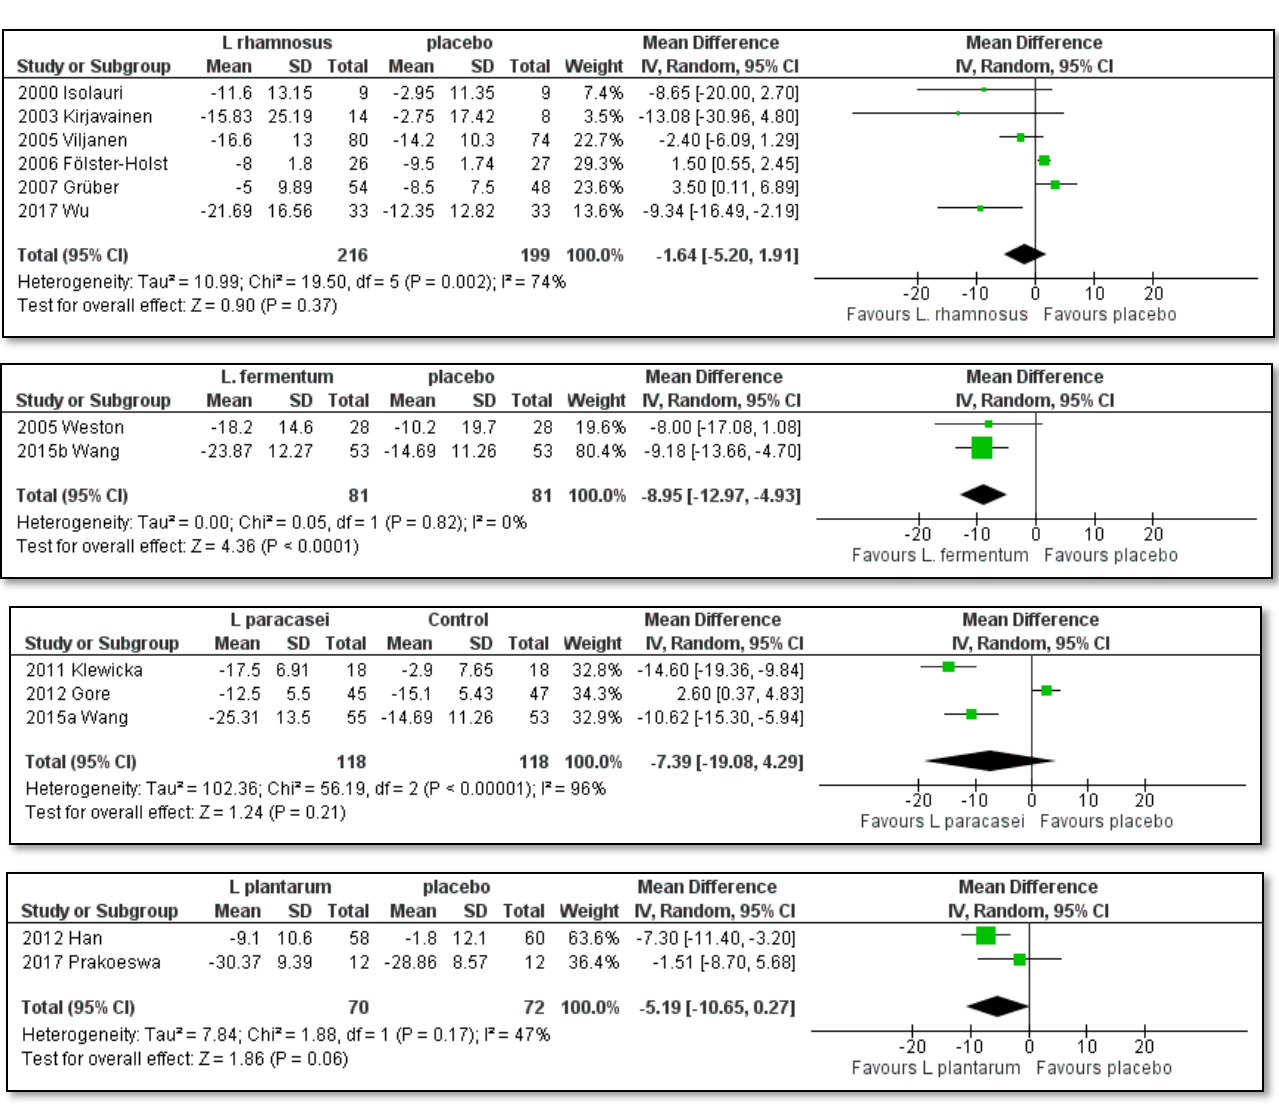
10 of 21 Figure 2. Meta-analysis of the e ff ect of single-strain probiotic lactobacilli compared to placebo on the SCORAD index change in children with AD [41–44,46–55]. A total of 1.124 children were assessed (574 in the single-strain probiotic lactobacilli group and 550 in the placebo group). A statistically signi fi cant di ff erence was found in favor of all included single-strain probiotic lactobacilli compared to placebo (mean di ff er-